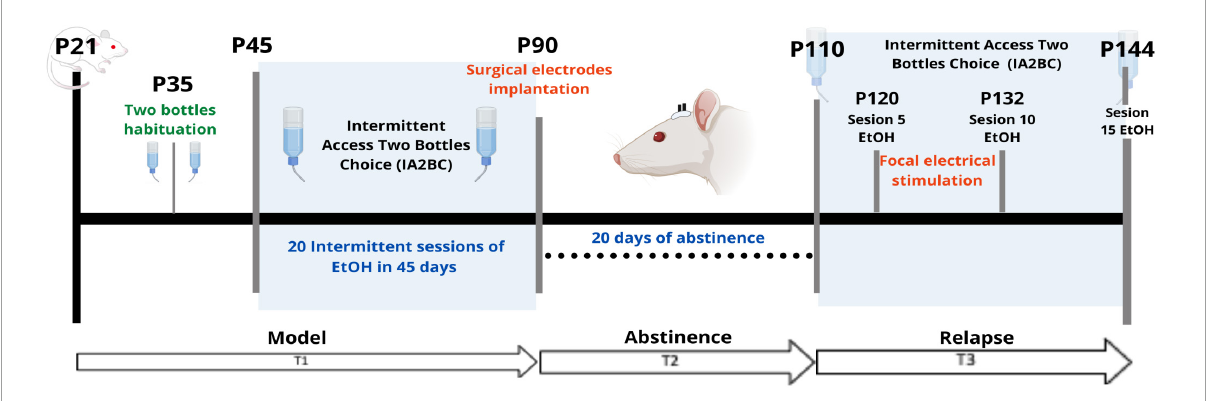
FIGURE1 Experimental outline. T1 (Time 1) corresponds to the time encompassing the onset of IA2BC. T2 (Time 2) separates the 20-day period of abstinence. T3 (Time 3) corresponds to the phase of the model where the relapse phenomenon was observed. P, Postnatal age in days. EtOH, 20% ethanol.